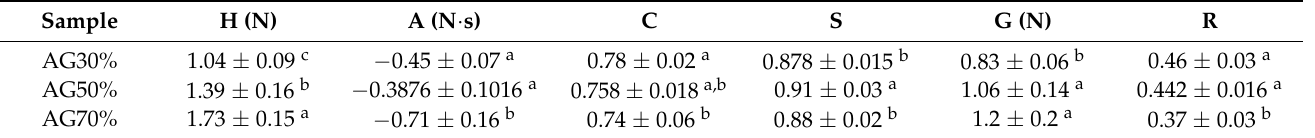
Table 2. TPA test